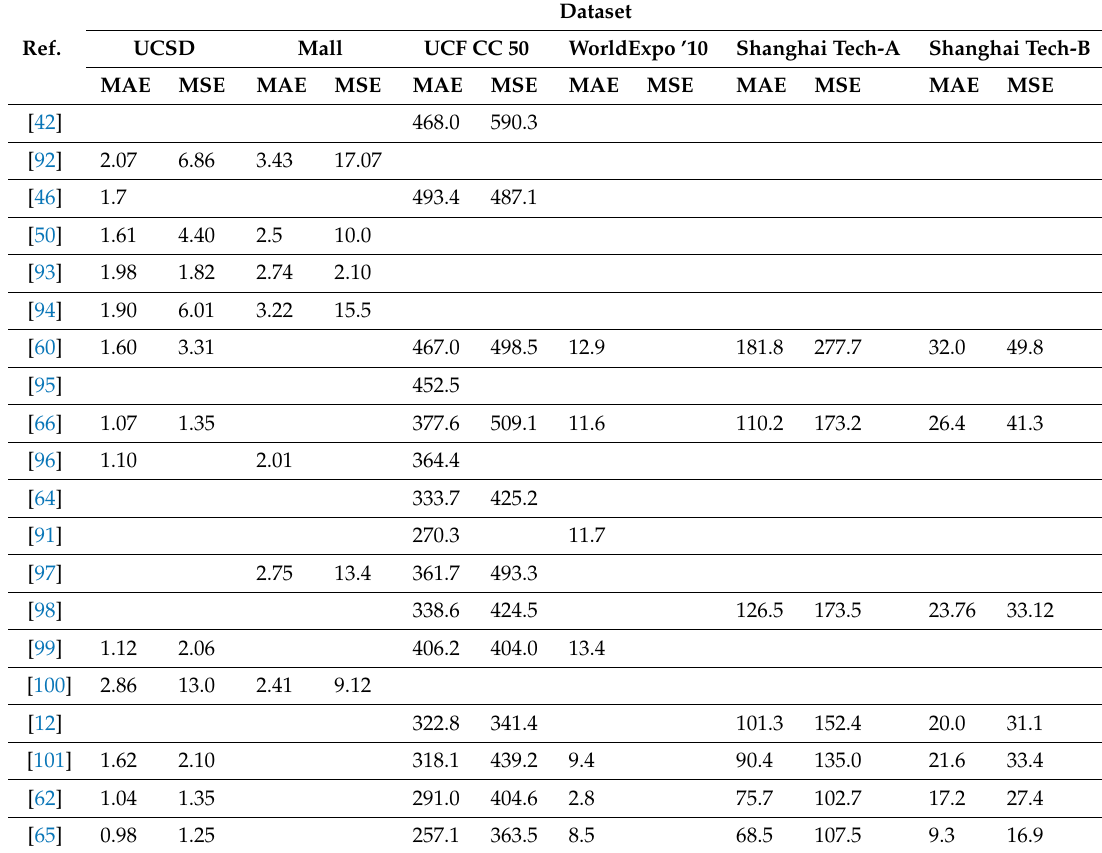
Table 4. Comparison of state-of-the-art crowd scene counting algorithms.